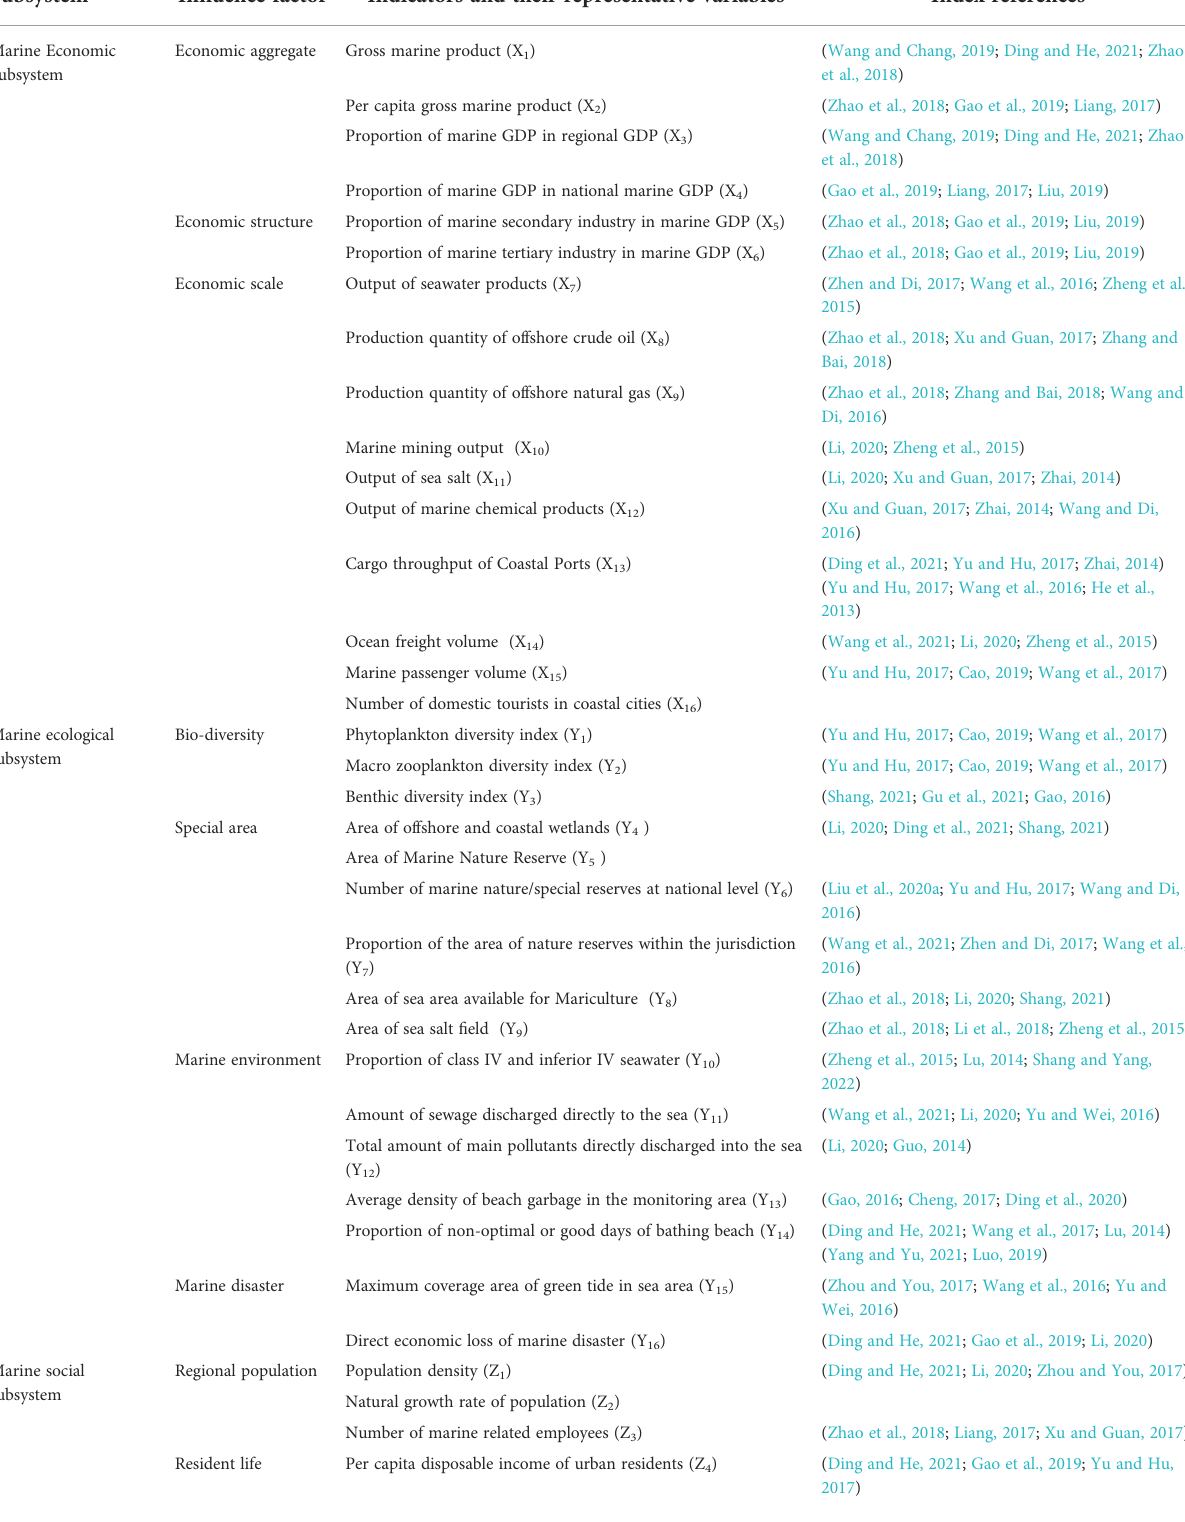
TABLE 3 The measurement index system of the conjugation degree of the marine composite